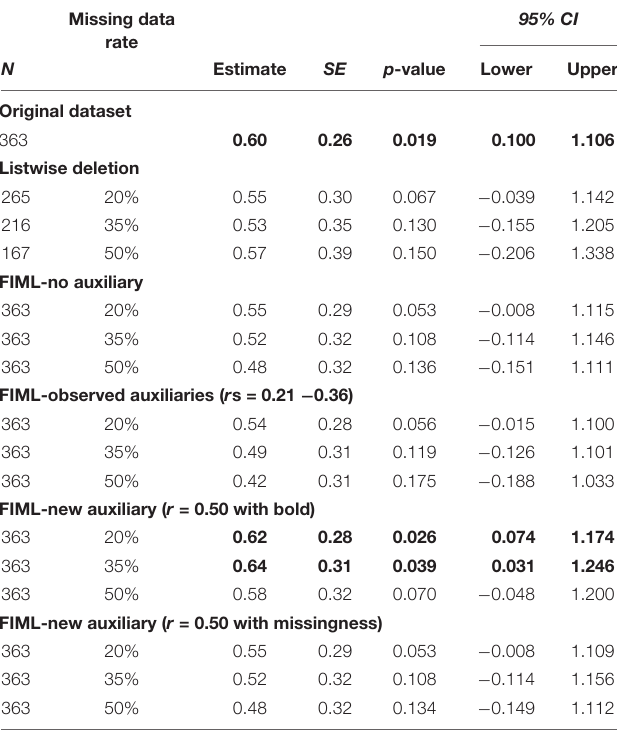
TABLE 3 | Putamen signal predicting Body Mass Index (BMI) latent change score: estimates across missing data conditions. Missing data